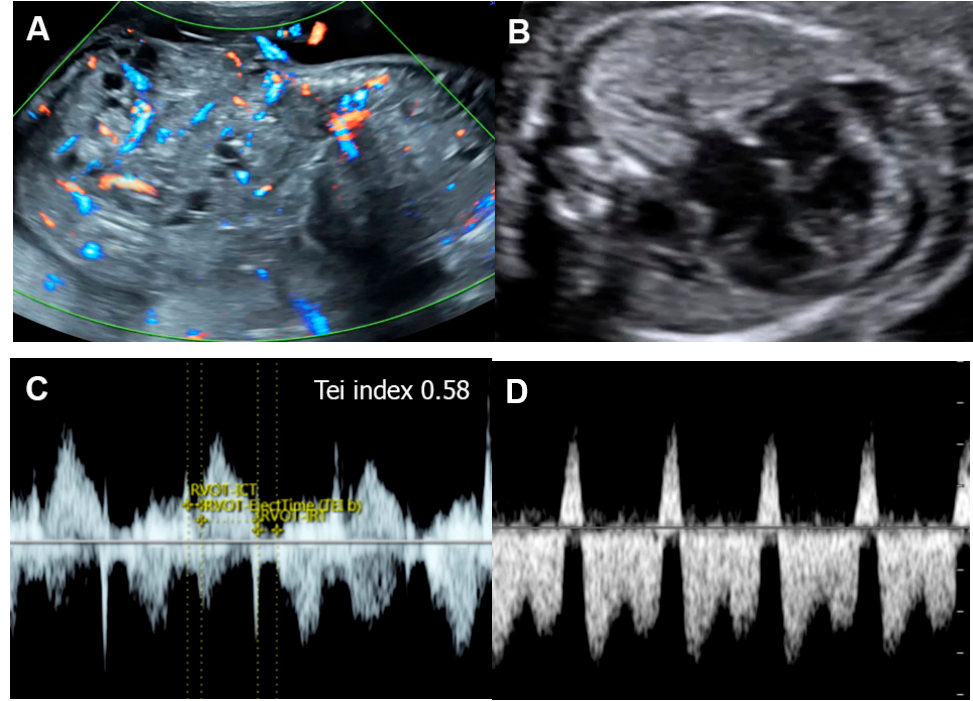
Figure 6. Cardiac dysfunction of a fetus with sacrococcygeal teratoma (SCT): ( A ) vascularized SCT; ( B ) global cardiomegaly with pericardial effusion; ( C ) increased Tei index (0.58) with prolonged IRT (44 ms); ( D ) Doppler markedly reversed A-wave in the ductus venosus. The severity of cardiac overload is directly related to the volume of shunting, usually directly correlated with the tumor size or the acardiac twin size relative to fetal weight [112,113]. The cases with higher shunting volume or huge tumor mass have a high peri- natal morbidity and mortality rate. As consequences of volume overload, the fetuses de- velop global cardiomegaly, increased cardiac output and cardiac dysfunction in varying degrees of severity. Typically, to cope with the cardiac overworking, compensatory after- load reduction occurs. However, when compensatory afterload reduction is over- whelmed, AV valve insufficiency or low CVPs can be expected. The measurement of com- bined cardiac output may be used to predict fetal compromise [114] and to guide the need for intrauterine intervention. It has been suggested that combined cardiac outputs of two- fold or greater of the reference range may be a cut-off for the development of FHF in sac- rococcygeal teratoma or agenesis of the ductus venosus [115,116]. Fetal hydropic changes or fluid collection in the body cavities may develop in severe cases [117], though cardiac contractility or shortening fraction may be normal, hyperdynamic, or poor in advanced stages. Fetal echocardiography usually shows some degree of cardiac compromise, espe- cially an increase in cardiac output [118,119] and a lower cardiovascular profile score (CVPs) [120], as well as abnormalities of venous Doppler waveforms. These fetal echocar- diographic findings are also very helpful as guidance for prenatal intervention, such as obliteration or embolization of the main vessels feeding the tumor or perivascular sclero- sis, surgical debulking of the tumor, arterial ligation, radiofrequency ablation of vessels of an acardiac twin, etc. Additionally, serial assessment of cardiac function in less severe cases is necessary for early detection of cardiac dysfunction or decompensation. The use- ful parameters for assessment include cardiac size, ventricular dilatation, combined car- diac output, spectral Doppler flow of the IVC, the ductus venosus or the umbilical vein as well as severity of AV valve regurgitation. Of note, different from volume load caused by anemia in which low viscosity and a marked decrease in afterload play an important role in the reduction of cardiac pressure load, the volume load in fetuses with non-anemic high output is associated with more rapid and severe cardiac pressure load and is more likely to cause FHF than anemic causes. Increased Afterload Increased ventricular afterload can eventually result in FHF, when compensatory mechanisms become exhausted. The causes of increased afterload are as follows: (1) blood flow obstruction in the heart, such as aortic stenosis, pulmonary stenosis, restrictive fora- men ovale and constriction of the ductus arteriosus. (2) Extra-cardiac causes, including increased systemic vascular resistance caused by placental insufficiency as commonly seen in fetal growth restriction and twin-twin transfusion syndrome (TTTS).